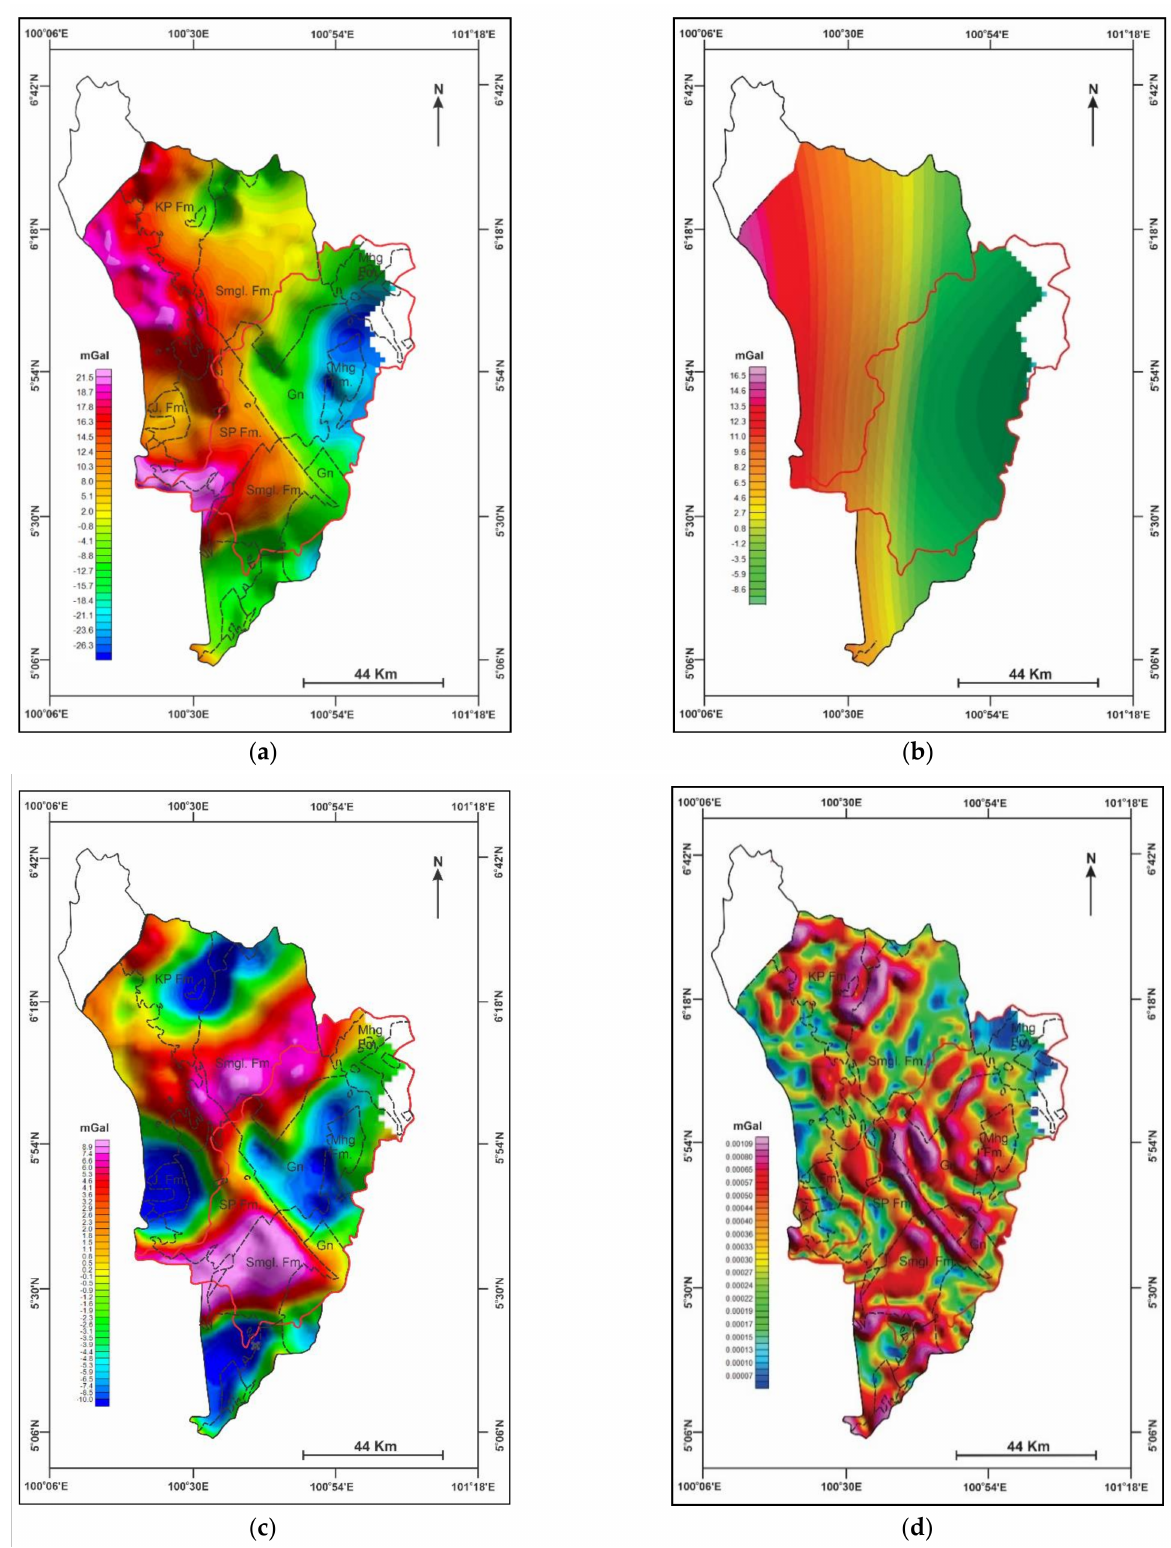
Figure 6. ( a ) complete Bouguer anomaly (CBA) map; ( b ) Regional CBA anomaly map; ( c ) Residual CBA anomaly map; ( d ) THD Map. All the maps were overlayed with the geological contacts between formations of Mahang (Mhg), Semanggol (Smgl), Kubang Pasu (KP), Jerai (J), and granitic (Gn)